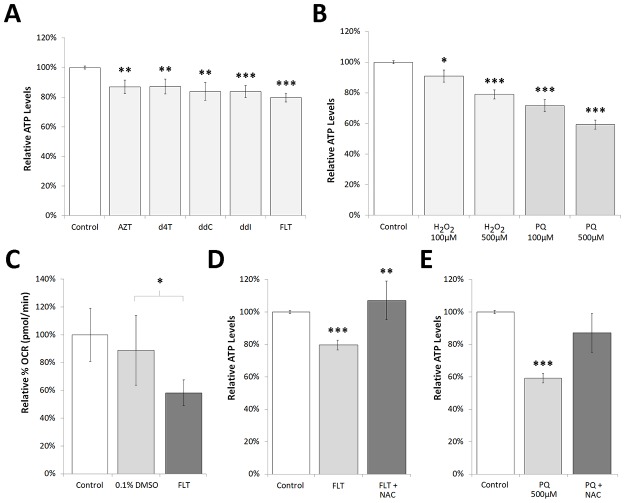
A: ATP levels were immediately perturbed upon exposure to NRTIs and B: pro-oxidants paraquat (PQ) and hydrogen peroxide (H2O2). Relative ATP levels (%) declined significantly within 2.5 minutes upon exposure to NRTIs (≥7 replicates in 4 individual experiments) and pro-oxidants (≥7 replicates in 3 individual experiments) in vivo, compared to the control (0.33% DMSO). C: OCR was immediately reduced upon exposure to FLT. Oxygen consumption rate (OCR) was reduced within 5 minutes exposure to FLT. Statistics were calculated with a one way ANOVA with Dunnett’s multiple comparisons test. Error bars indicate standard error for ≥2 replicates of 20 worms per ≥3 conditions. D: ATP level decrease by FLT and E: paraquat were attenuated upon exposure to 100μM NAC. ATP levels were measured at 2.5 minutes after exposure in vivo. ATP statistics were calculated with a two-way ANOVA with replication. FLT and PQ compared to control and FLT and PQ + anti-oxidant compared to FLT or PQ alone (≥3 replicates in 3 individual experiments). * = P<0.05, ** = P<0.01, *** = P<0.001. NRTI concentration = 200μM.